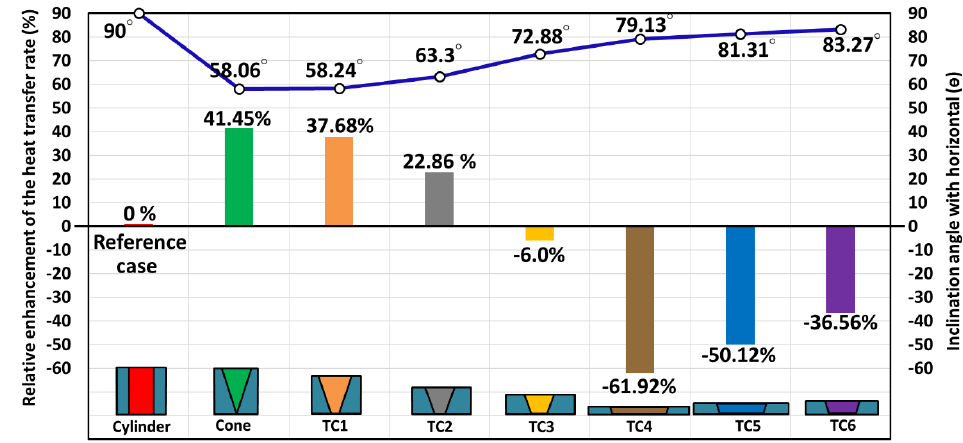
Figure 9. Relative enhancement of the heat transfer rate in the truncated conical MH bed (Case 2) compared to the basic cylindrical Case 1 (i.e., different geometric parameters are tested according to Table 3).